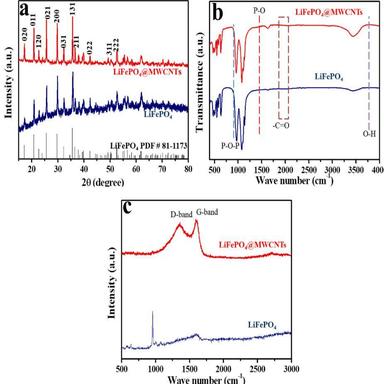
XRD (a); FT-IR (b) and Raman (c) spectra of LiFePO4 and LiFePO4@MWCNTs composite.